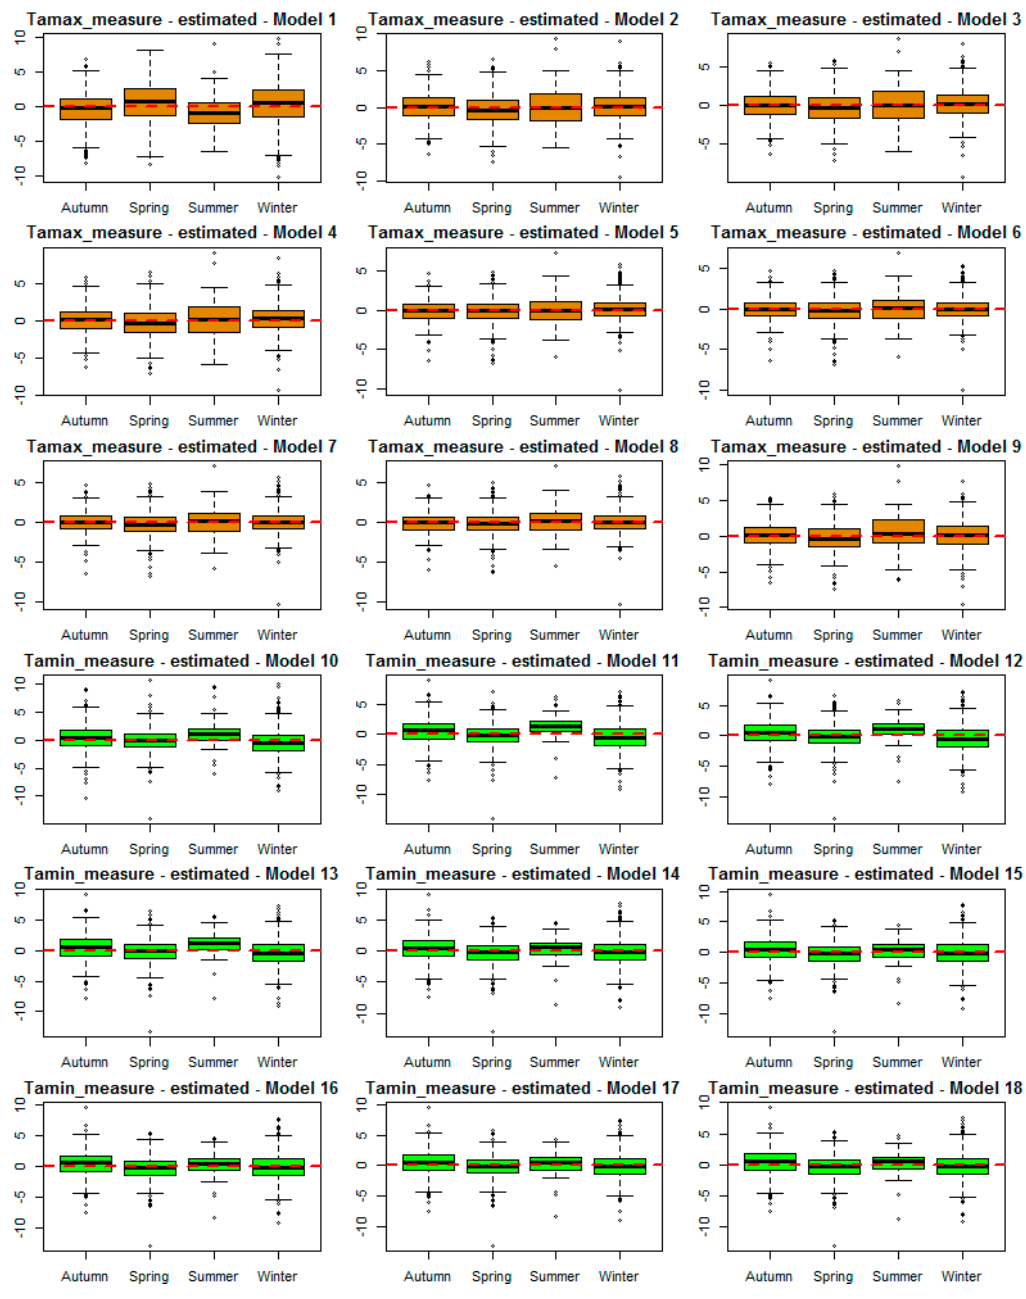
Figure 7. Box-plots with the difference between T a -estimated and T a -measured by season in years. The line within the box indicates the median. The bottom of the box is the first quartile, and the top is the third quartile. Whiskers represent the lowest value still within 1.5 IQR (IQR = third quartile − first quartile) and the highest value still within 1.5 IQR. The black plus mark indicates the outliers.